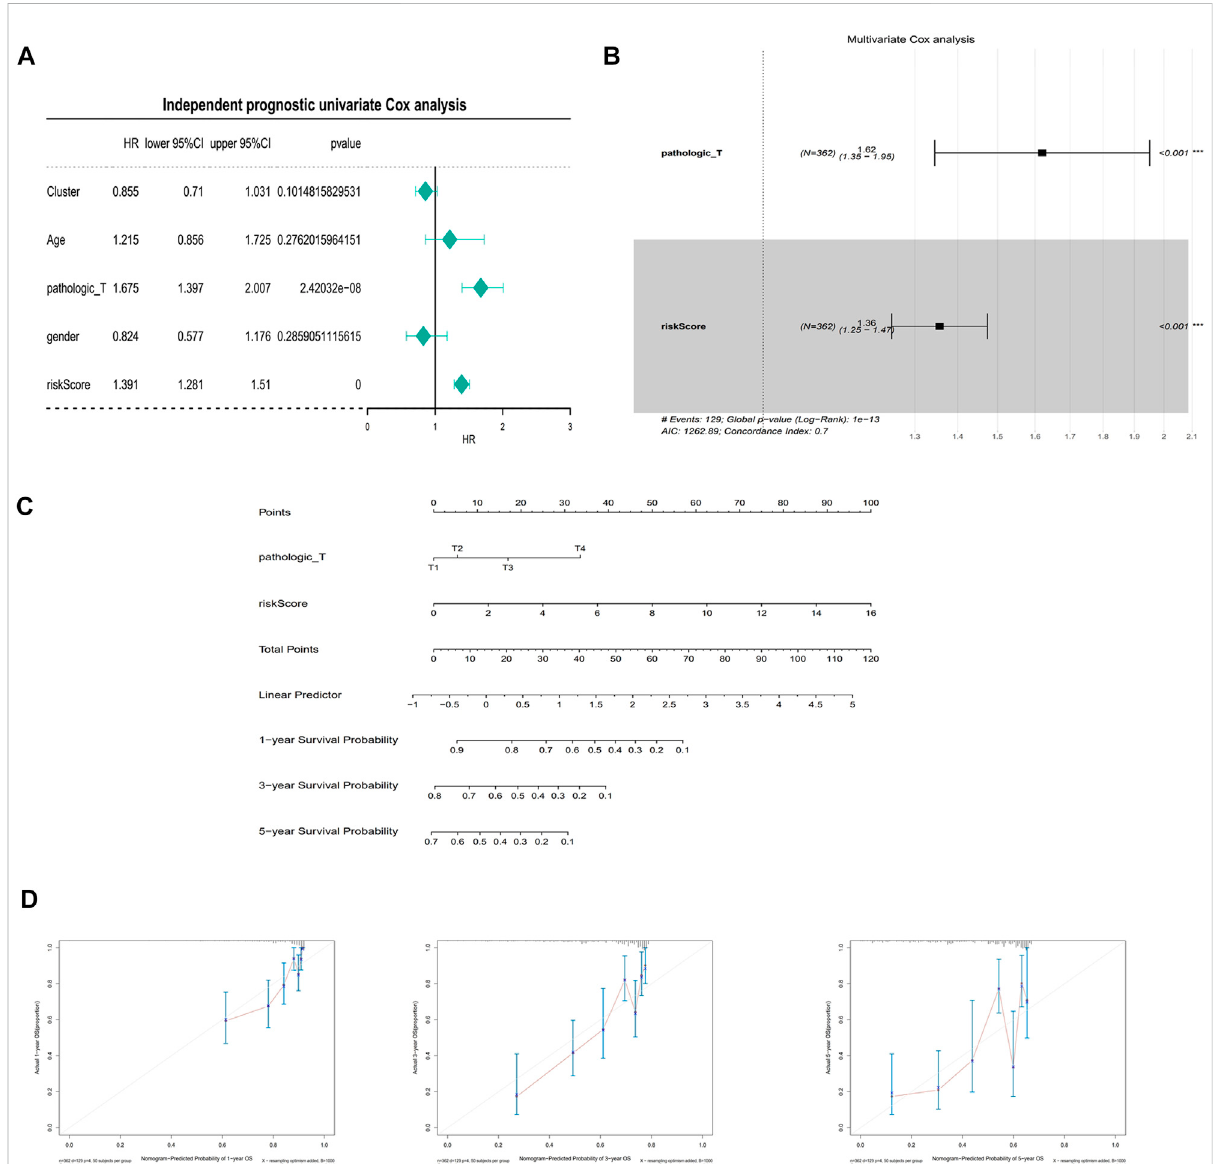
FIGURE 7 Independent prognostic analysis and building of a nomogram. (A) Univariate Cox independent prognostic analysis in the training set. (B) Multivariate Cox independentprognostic analysis in training set. (C) A nomogram predicting overall survivalfor HCC patients. For eachpatient, three linesaredrawnupwardtodeterminethepointsreceivedfromthethreepredictorsinthenomogram.Thesumofthesepointsislocatedonthe ‘ Total Points ’ axis. Then a line is drawn downward to determine the possibility of 1-, 3-, and 5-year overall survival of HCC. (D) The calibration plot for internal validation of the nomogram. The Y -axis represents actual survival, and the X -axis represents nomogram-predicted